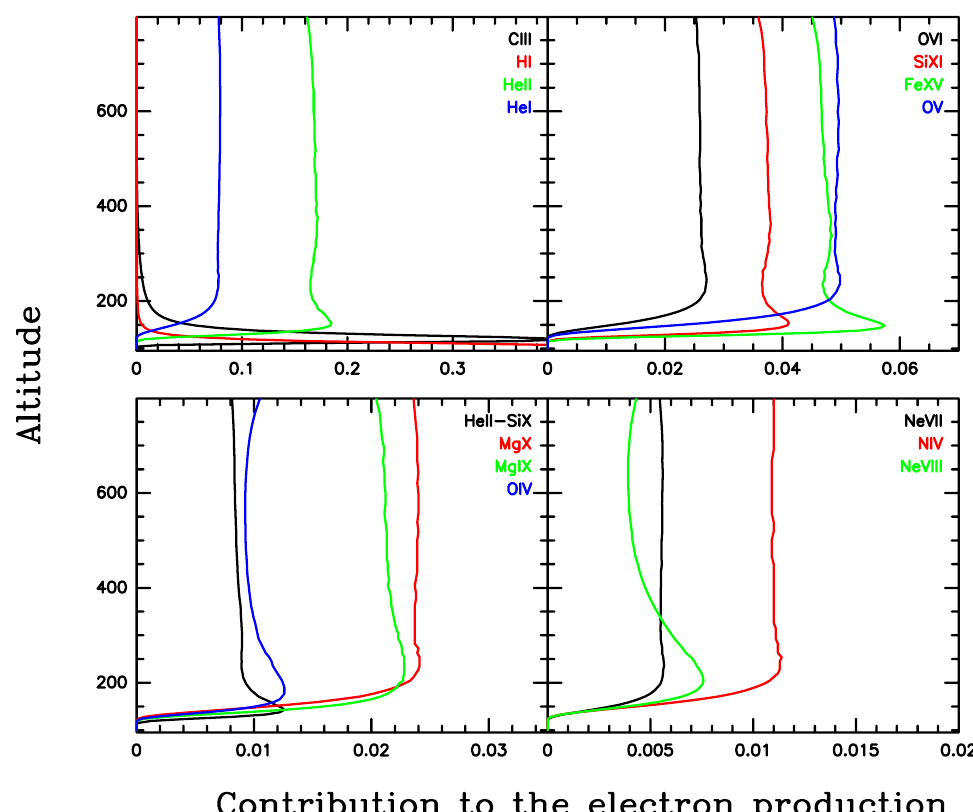
Fig. 4. Relative contribution of each spectral line to the total electron production versus the altitude in km.